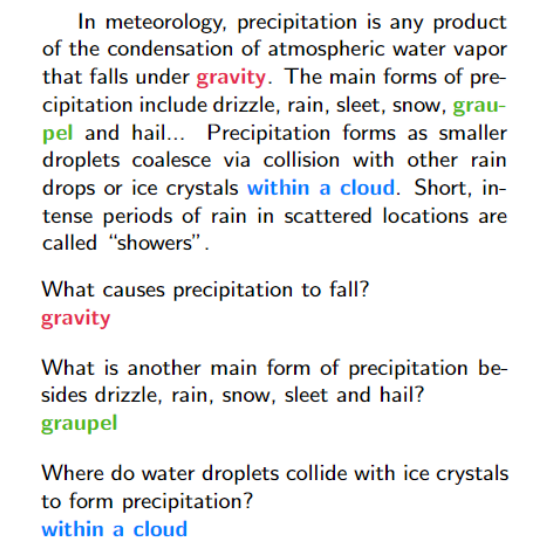
Figure 3. Span-extraction MRC [17]. Color fonts represent the answers of questions.